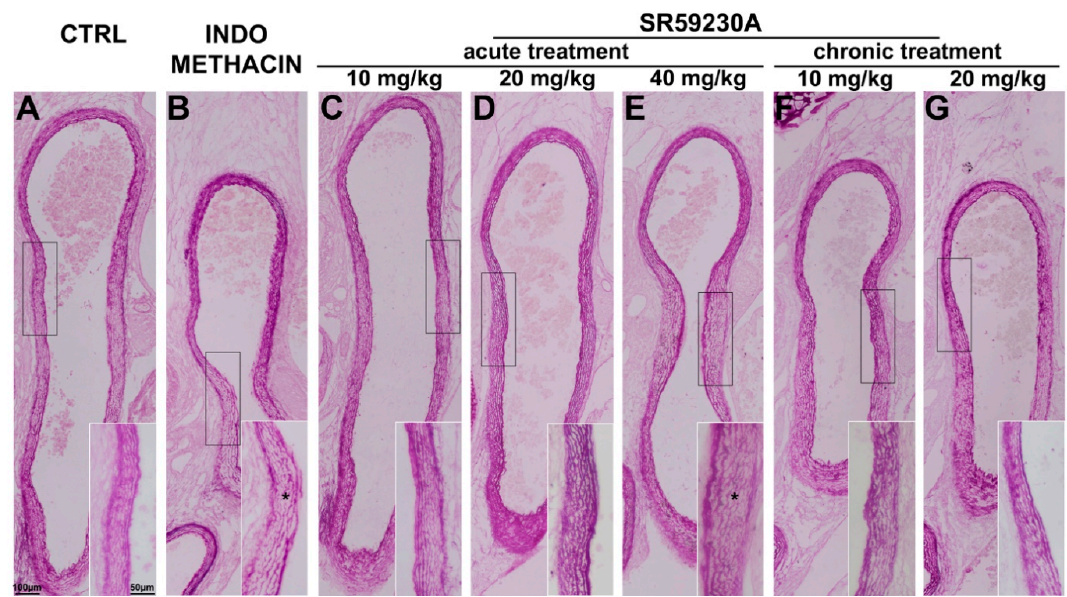
Figure 7. Morphological evaluation of the elastic fibers of the ductus arteriosus (DA) wall. Representative pictures of paraldehyde fuchsin stained sections of DA from fetuses of each experimental group ( A – G ). Compared with the untreated mice (CTRL) ( A ), the animals given 40 mg / kg SR59230A (E) or 20 mg / kg indomethacin ( B ) exhibited disassembled, sparse and thin elastic fibers in tunica media (asterisks). The treatment with SR59230A at 10 or 20 mg / kg did not alter the elastic fibers of the ductal wall ( C , D , F , G ). Scale bar is indicated in panel A . At least 20 fetuses of 5 litters were evaluated for each experimental group and the results reported are representative of five independent